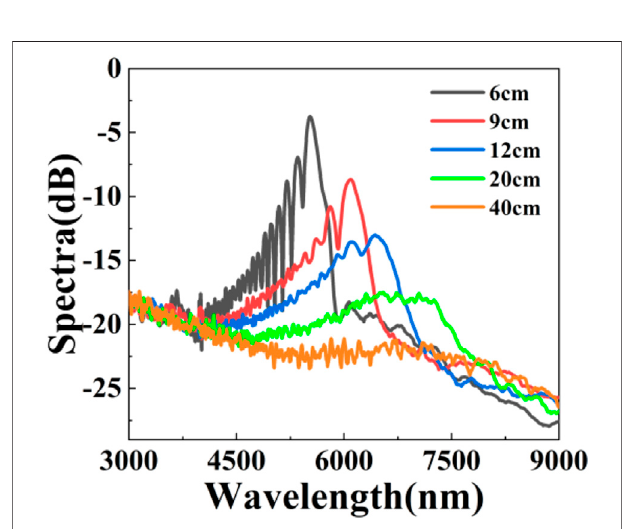
FIGURE 2 | Output mean spectra in different length DOFs ( P 0 (cid:2) 1.224 kW, β 21 (cid:2) 100 ps 2 /km, Λ (cid:2) 0.5 cm, φ (cid:2) 0).